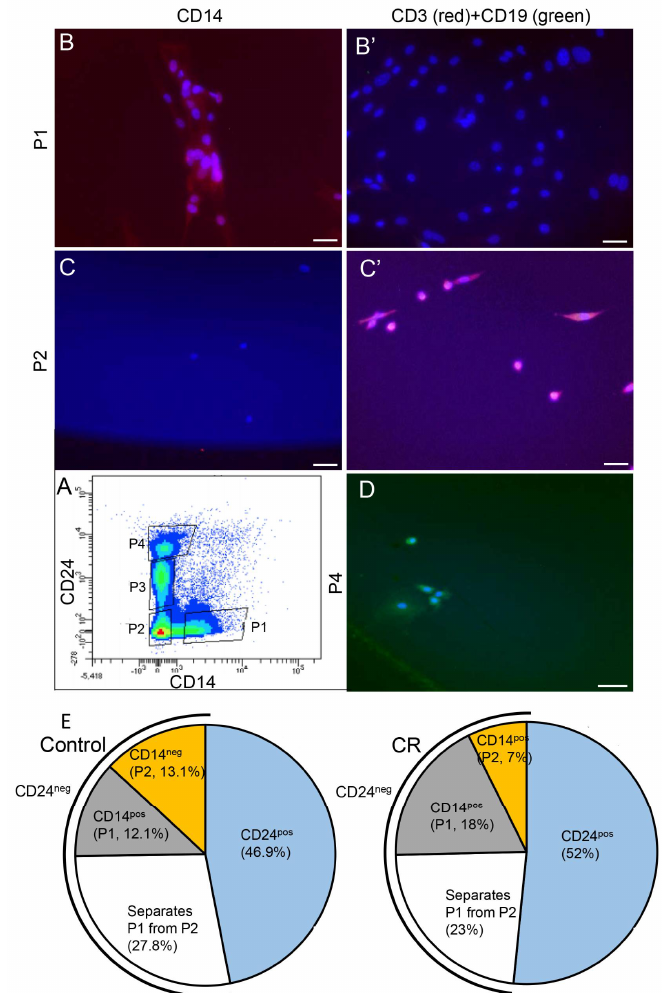
Figure 5. Lin - non-epithelial cell population contains distinguishable myeloid and lymphoid cell subpopulations. ( A ) Flow cytometry analysis separating subpopulations in the non-epithelial cells. ( B , B’ ) The P1 population (CD14 pos CD3 neg CD19 neg ) contains mainly monocytes/macrophages, but not lymphoid cells. ( C , C’ ) The P2 population (CD14 neg CD3 pos CD19 neg ) contains T cells, but not monocytes/macrophages or B cells. ( D ) The P4 contains B cells. ( E ) Pie charts demonstrating flow cytometry-based analysis of the proportion of each population among the Lin − live mammary cells. Three independent analyses were performed and the mean values are presented.